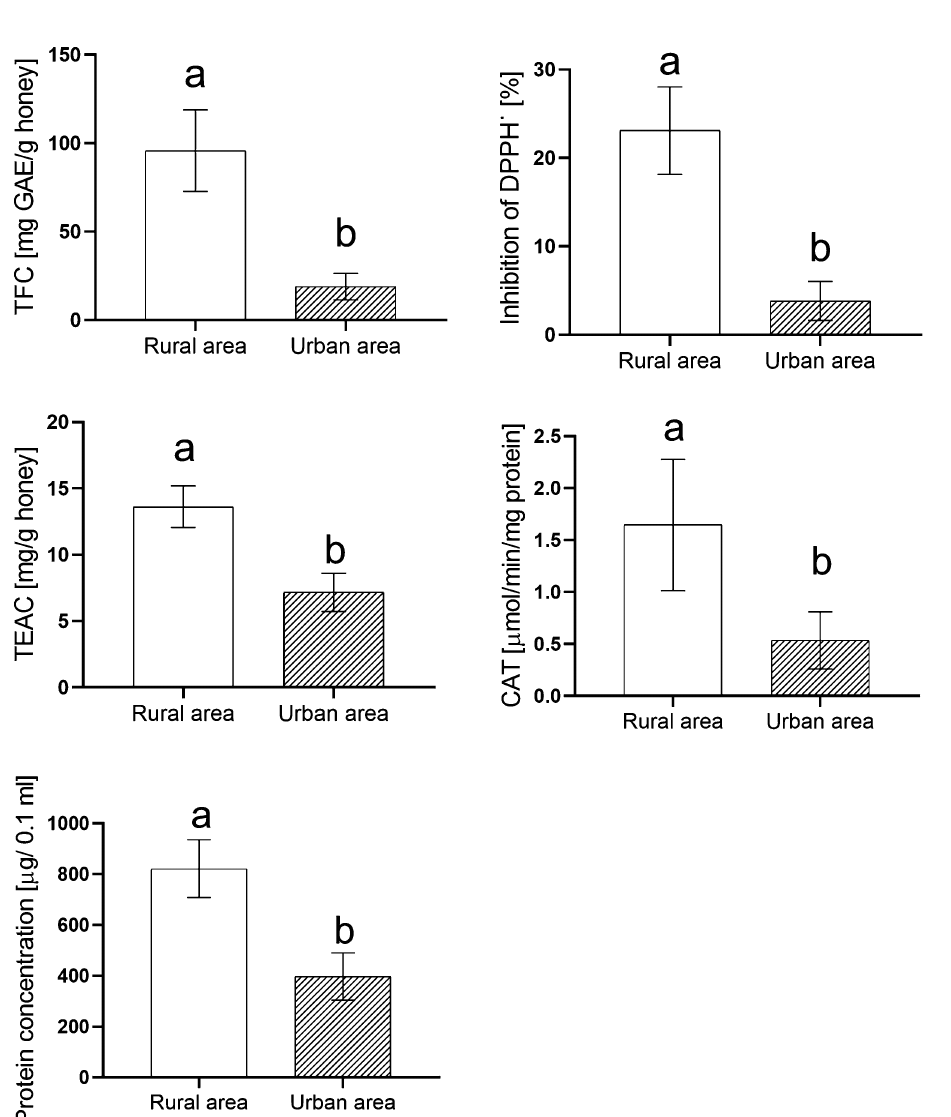
Figure 2. Comparison of antioxidant properties of honey from urban and rural areas. TPC (total phenolic content) is expressed as mg gallic acid equivalents per 100 g of honey sample (mgGAE/100 g). RSA (DPPH • radical scavenging activity) is expressed as a percent of inhibition of DPPH • radical. TEAC (Trolox equivalent antioxidant activity) is expressed as mg of Trolox equivalents per 100 g of honey. Catalase activity is shown as µmol H2O2 per min per mg protein (µmol/min/mg protein). The protein content is expressed as µg protein per 100 µl of honey solution. All values are presented as a mean ± SD. Different letters—significant differences. Student t-test. p ≤